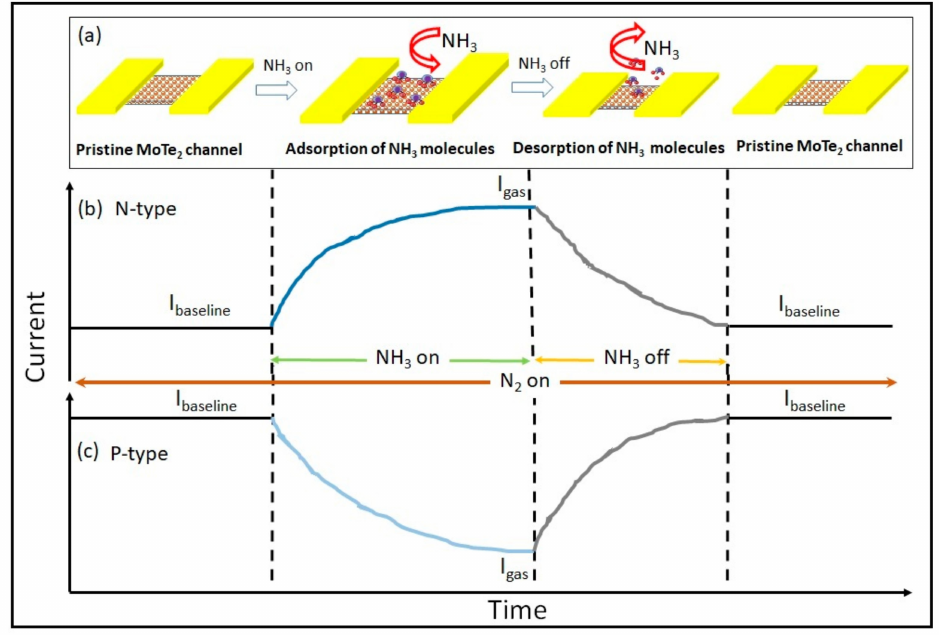
Figure 6. ( a ) Mechanism of NH 3 sensing. Schematic showing current–time curve of NH 3 sensing by ( b ) n-type and ( c ) p-type MoTe 2